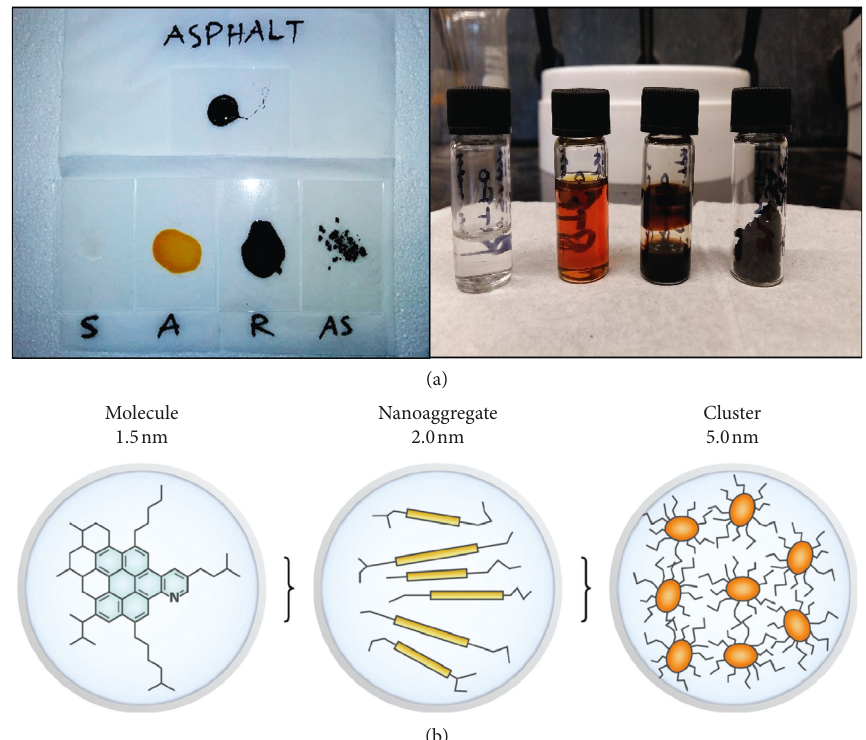
Figure 2: (a) Maltene (S � saturate, A � aromatic, R � resin), and (b) asphaltene (AS). The figure is reproduced from Mullins et al. (under the creative commons attribution license/public domain)